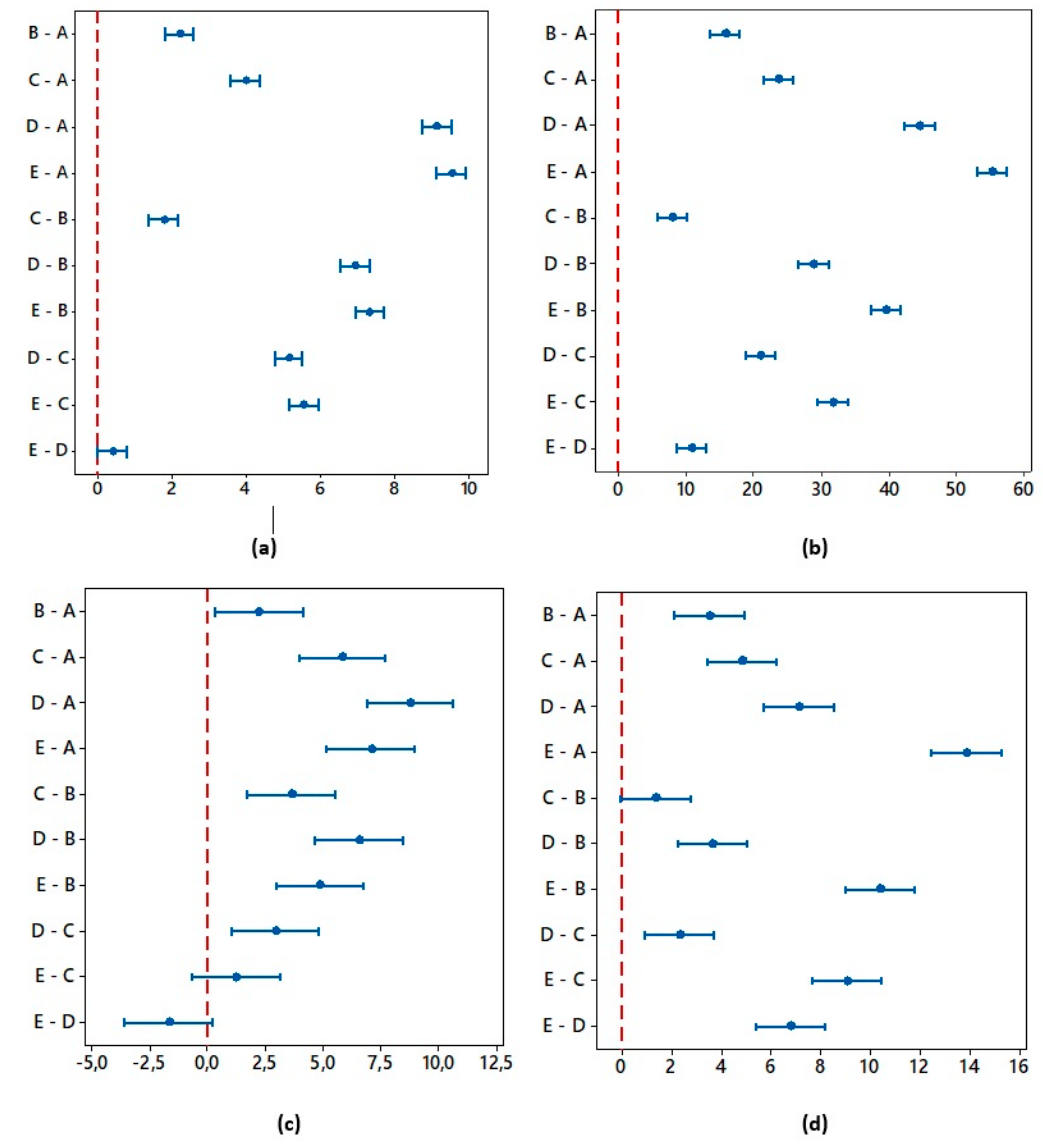
Figure 11. Tukey post-hoc test for ( a ) Ra, ( b ) Rz, ( c ) Rpk, ( d ) Rvk.